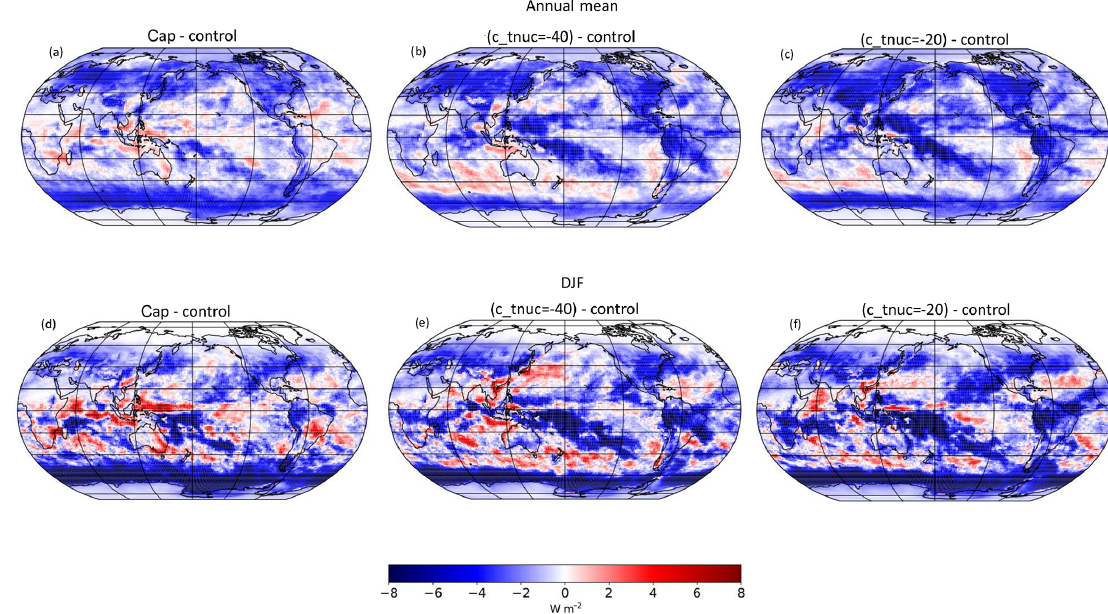
Figure 6. Spatial distributions of annual-mean (a–c) and DJF mean (d–f) SW CRE anomaly at TOA in different experiments with respect to the control model. (a, d) cap minus control, (b, e) ( c_tnuc=-40 ) minus control, (c, f) ( c_tnuc=-20 ) minus control. Values are calculated from daily-mean output over 22 years.